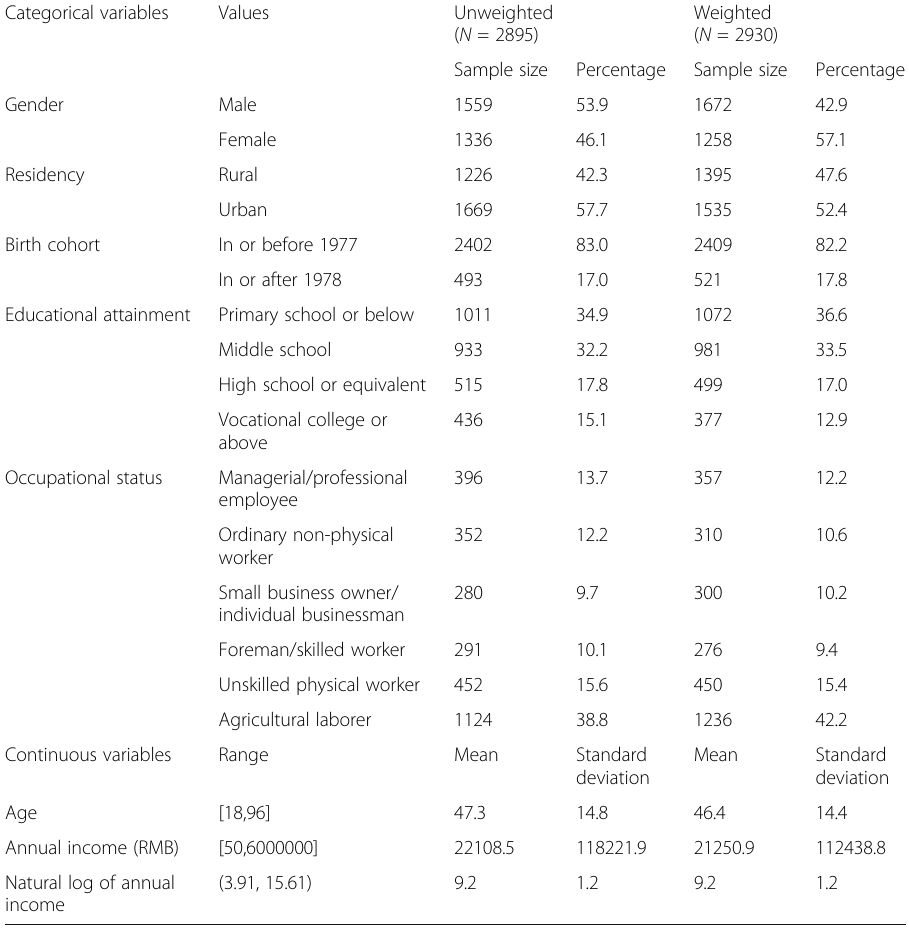
Table 1 Descriptive Statistics of the Sample of the Health Section (section M) in CGSS2010 Categorical variables